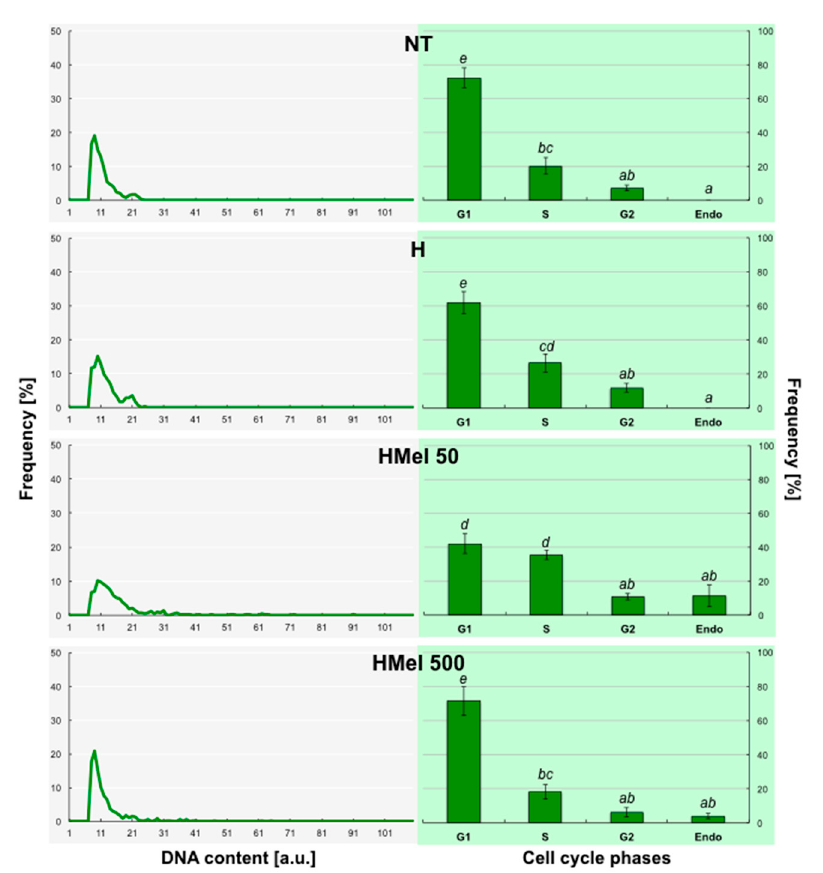
Figure 9. Effect of different maize seed hydropriming treatments on DNA content (line charts) and relative number of cells in G1, G2, S and > 4C phases/Endo (bar graphs) in the axes isolated from non-treated seeds (NT), and those from hydroprimed with water (H) and with melatonin water solutions in concentrations: 50 µ M (HMel 50) and 500 µ M (HMel 500). The seeds were imbibed/germinated for 24 h under optimal conditions 25 °C (C [ ■ ]—optimum, control conditions). The results of cell cycle phase distribution are expressed as means of 5 analyses ±SEM. Two-way ANOVA and Duncan’s post-hoc tests were performed. The lowercase letters next to the values show statistical significance at the specified p . Cell cycle phases distribution—ANOVA results: Seed Variant (NT,H,HMel 50,HMel 500) F (3;64) = 0, p = 1; Cell Phase (G1,S,G2,Endo) F (3;64) = 136.07, p < 0.0000001; interaction Seed Variant × Cell Phase F (9;64) = 4.85, p < 0.0001.